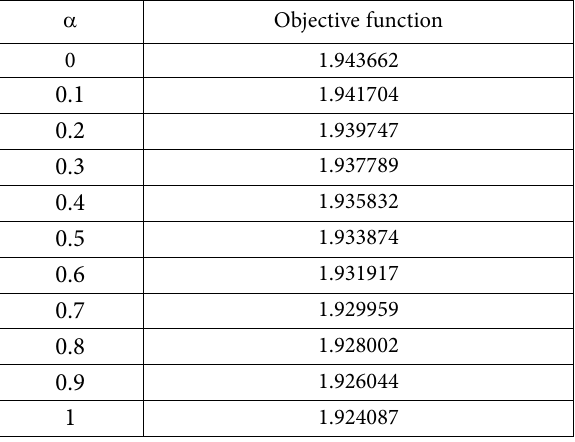
Table 6. The satisfaction degree of the objective function α Objective